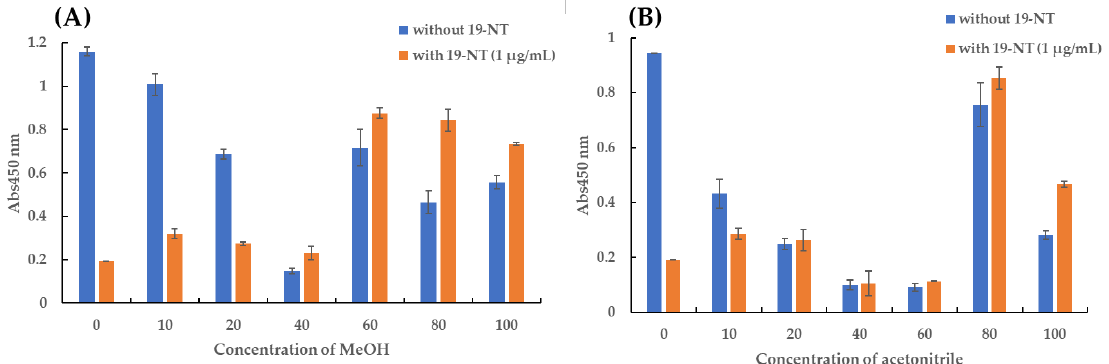
Figure 6. Binding activity of Nb3D10 in organic solvent by ELISA. A series concentration (0%, 10%, 20%, 40%, 60%, 80% and 100%) of ( A ) MeOH, ( B ) acetonitrile.